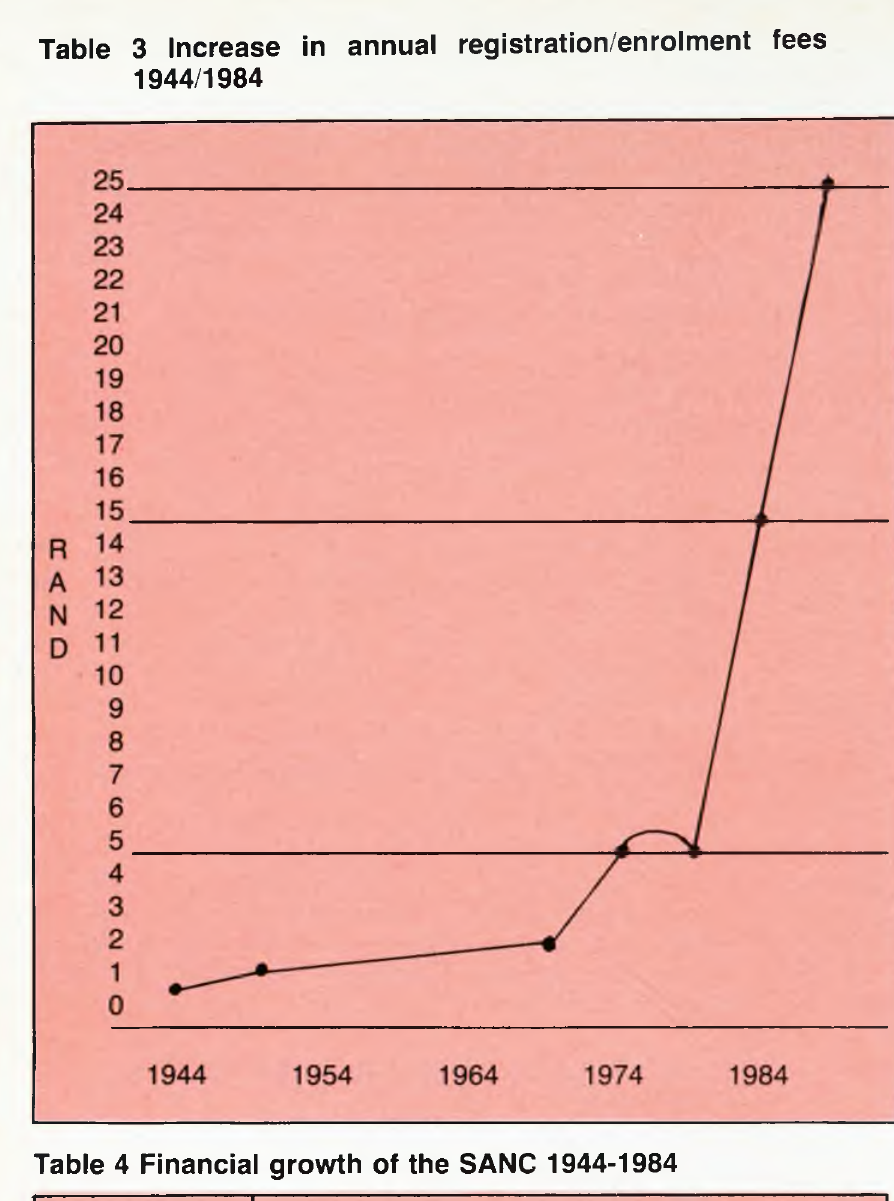
Table 4 Financial growth of the SANC